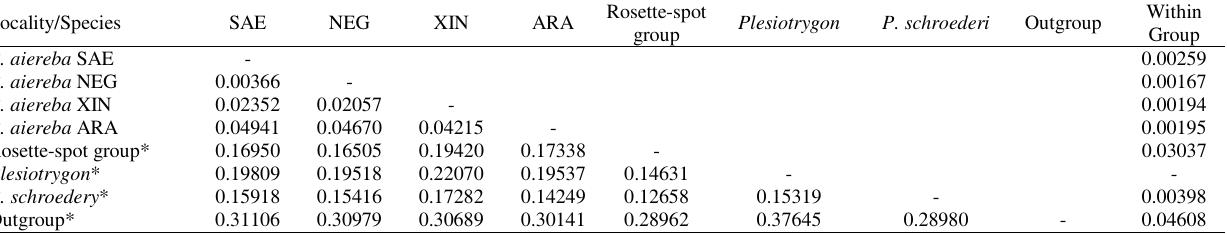
Table 2. Genetic distance using COI sequence data based in Kimura-two-parameter model of evolution. Pair-wise comparison between P. aiereba and other species/group from data of Toffoli et al . (2008). Note: SAE= Solimões-Amazon River and Estuary, NEG= Negro River, XIN= Xingu River, ARA= Araguaia